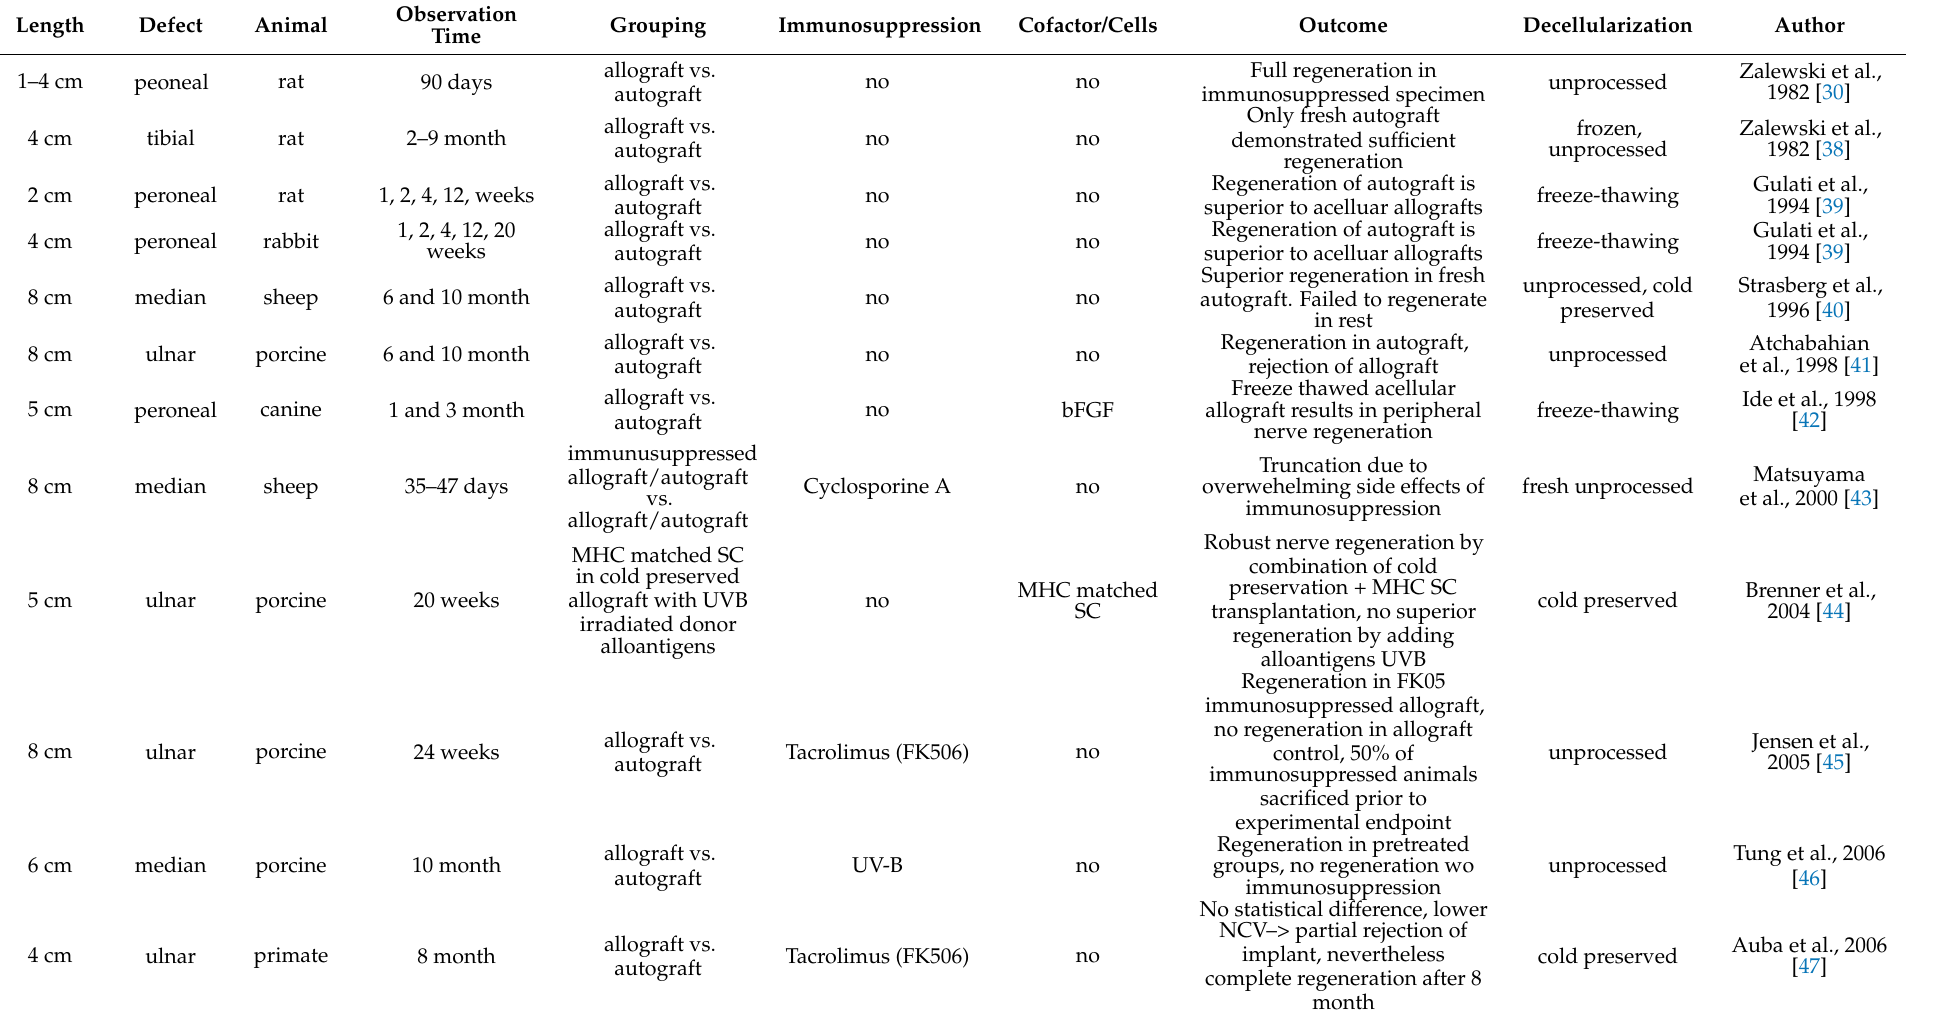
Table 1. Pre-clinical use of cadaveric